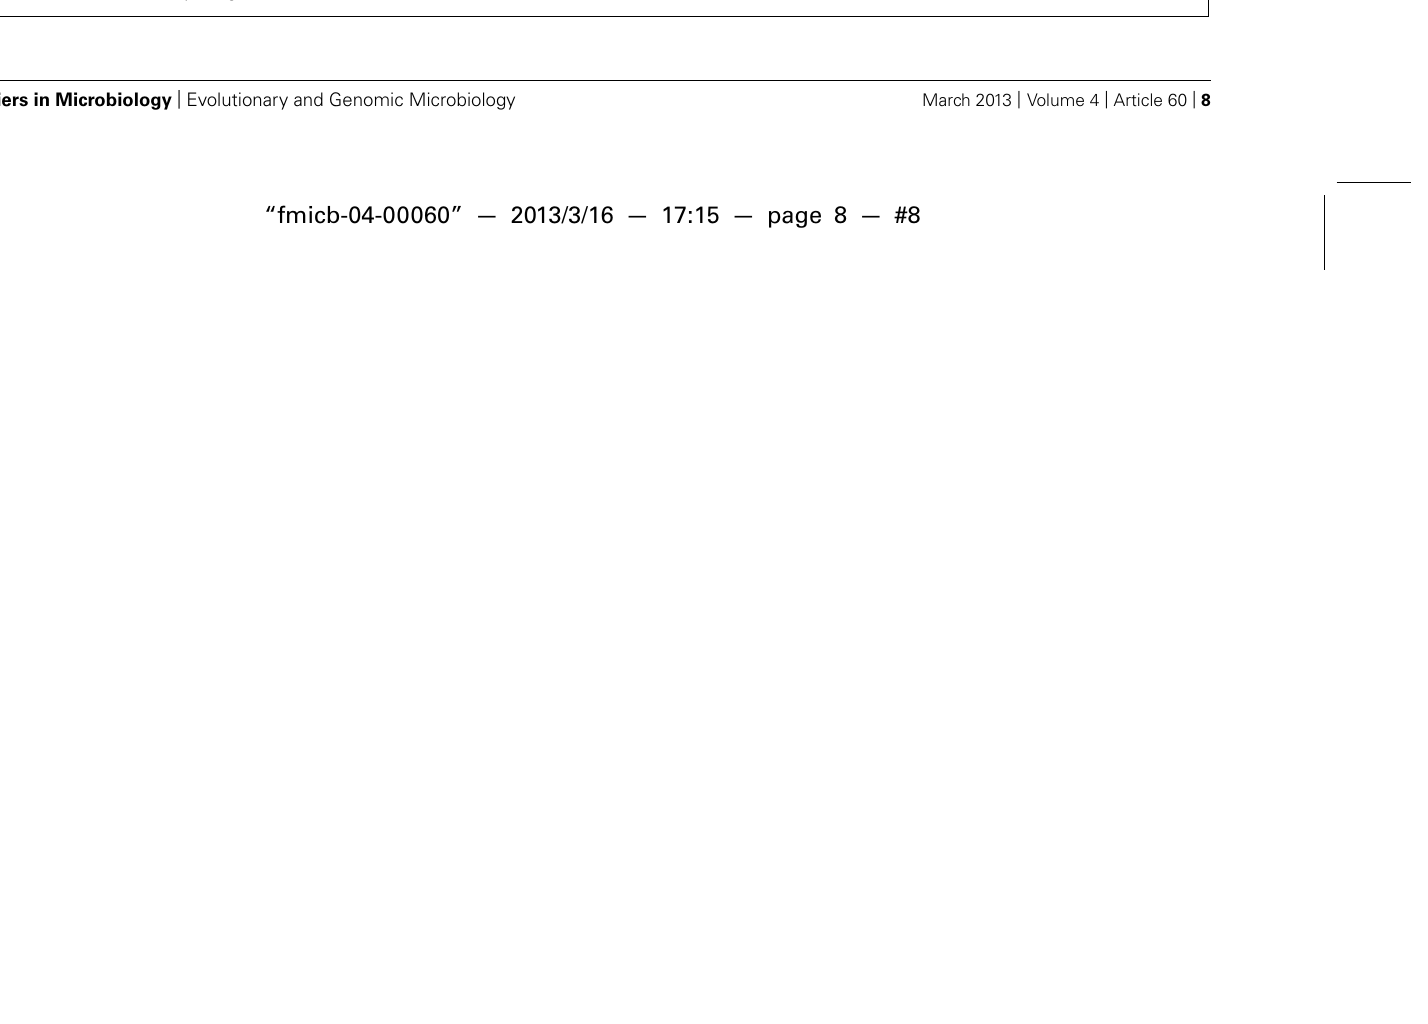
Frontiers in Microbiology | Evolutionary and Genomic